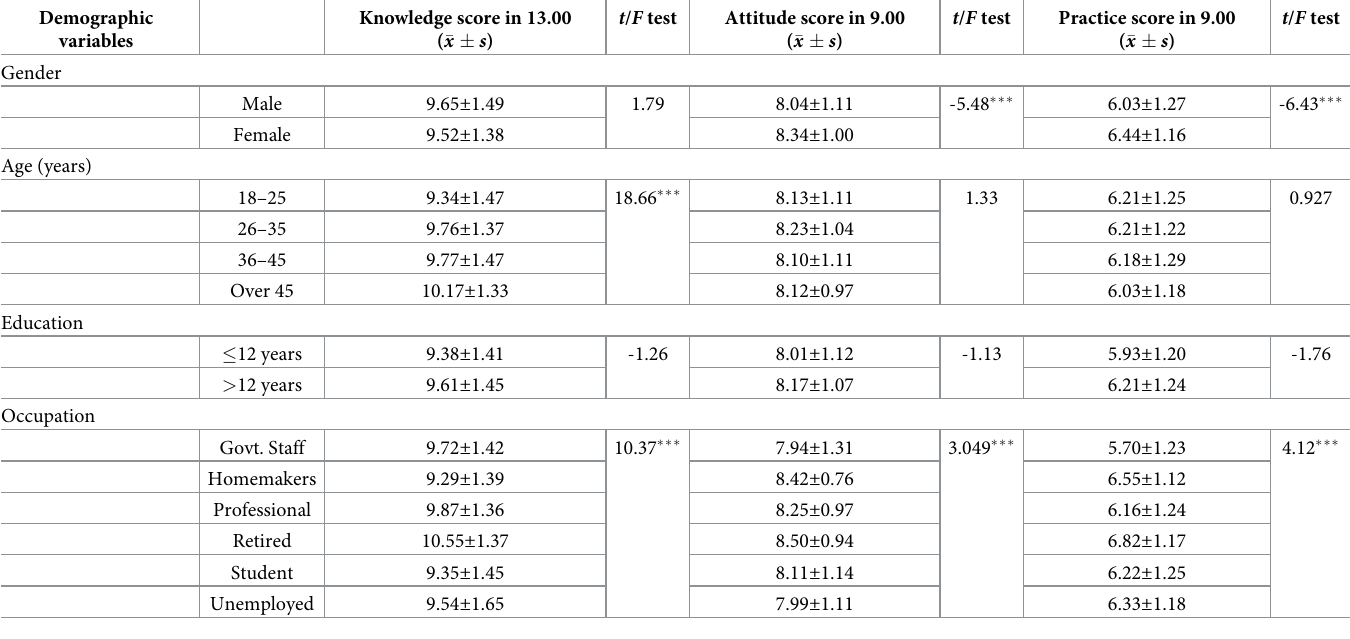
Table 2. Sociodemographic distribution of the participants and their KAP scores. Demographic